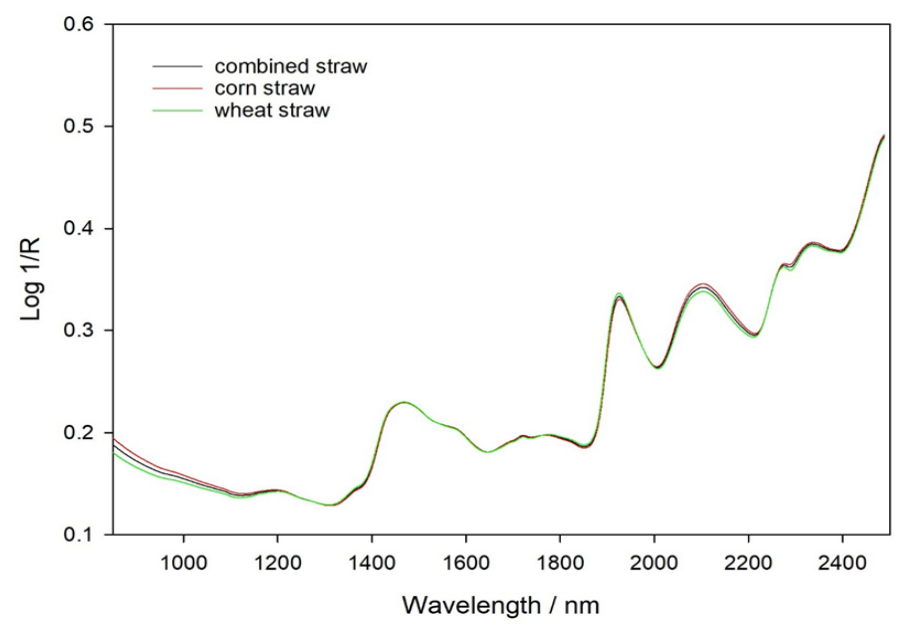
Figure 1. NIRS absorption average spectra of corn stover, wheat straw, and combined straw samples.